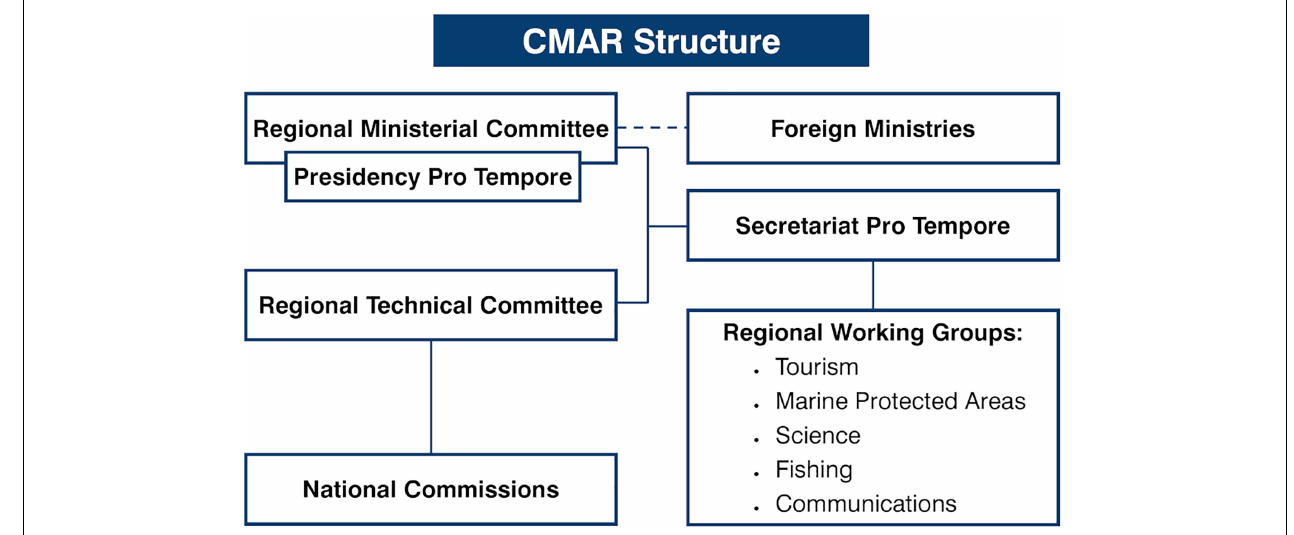
FIGURE 2 | Structure of CMAR (This diagram is based on the structure presented in the CMAR Action Plan 2019–2024, p.